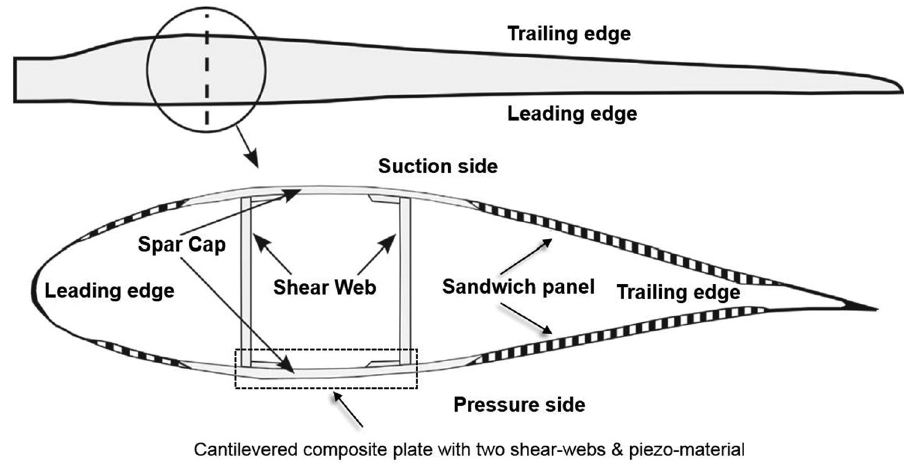
Figure 1: Cross - section of a wind turbine blade.